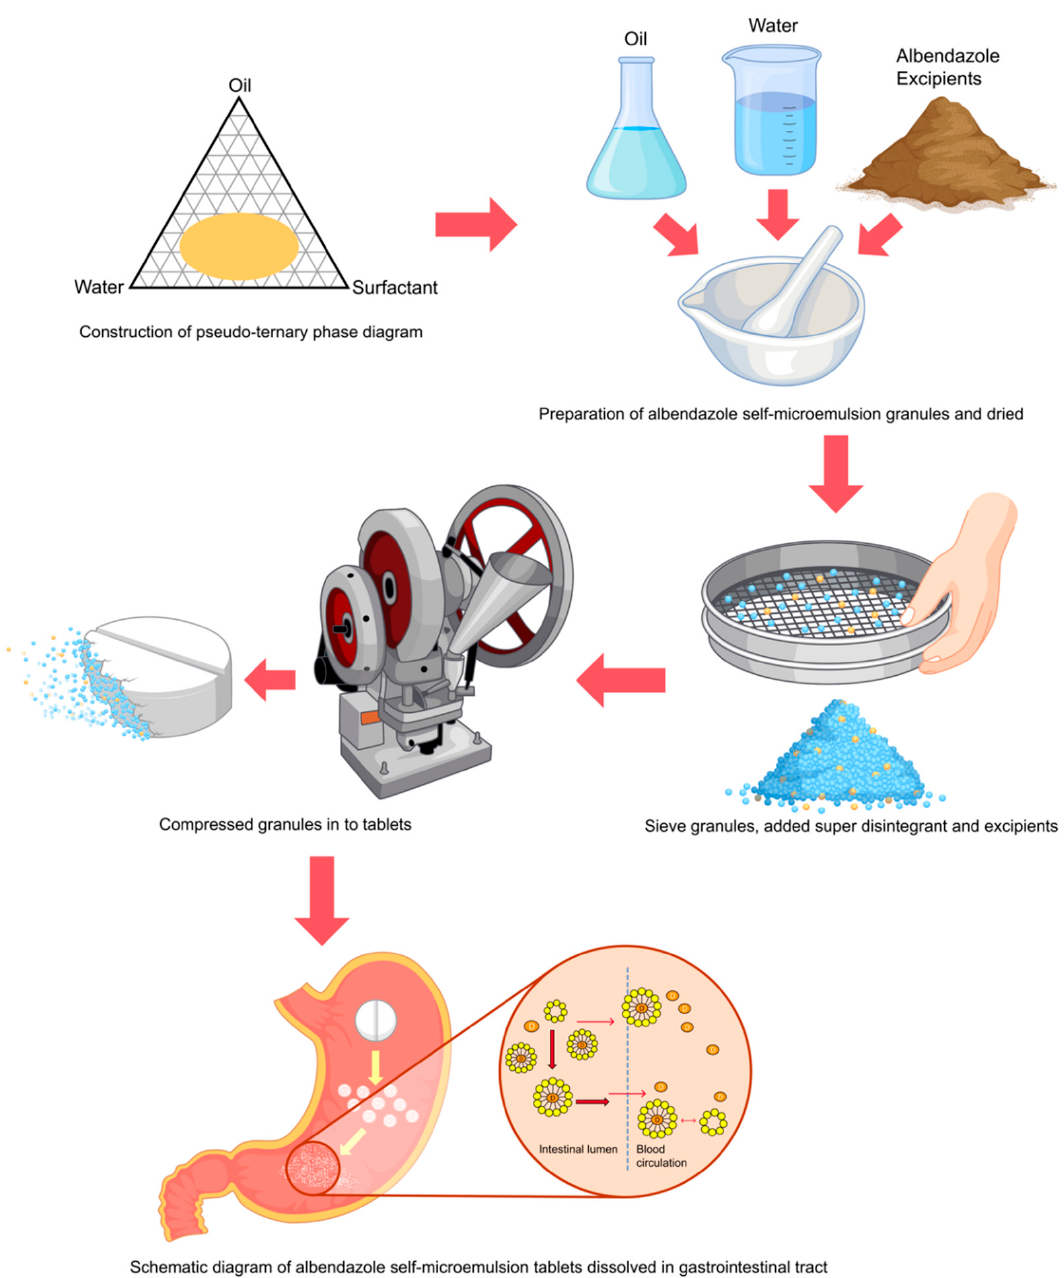
Figure 2. Schematic diagram of the method preparation of albendazole self-microemulsifying drug delivery system (SMEDDS) chewable tablets with a proposed dissolution mechanism enhancing